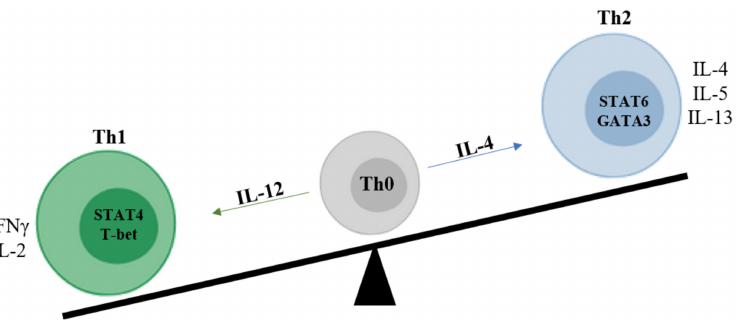
Figure 2. Th1-Th2 imbalance. Upon T-cell activation, IFN- γ , and IL-12 induce the expression of T-bet and STAT-4, which is involved in the differentiation of naïve CD4+ T cells into Th1 lymphocytes. Th1 cells predominantly produce pro-inflammatory cytokines such as IFN- γ and IL-2. In contrast, IL-4 induces the GATA-3 transcription factor and the consequent polarization of naïve T cells into Th2. Th2 cells produce anti-inflammatory cytokines such as IL-4, IL-5, and IL-13. Several studies have suggested that pSS is related to abnormal Th1 activation and SGs infiltration. It is supported by the presence of elevated levels of IFN- γ in serum and Th1 cells in blood. Furthermore, T cells expressing a high level of IFN- γ and STAT-4 mRNA have been found in SGs from pSS patients. This Th1/Th2 imbalance, generally observed in various chronic inflammatory disorders, is not easily understood because of a limited number of studies. Abbreviations: IFN- γ :interferon gamma; IL-: